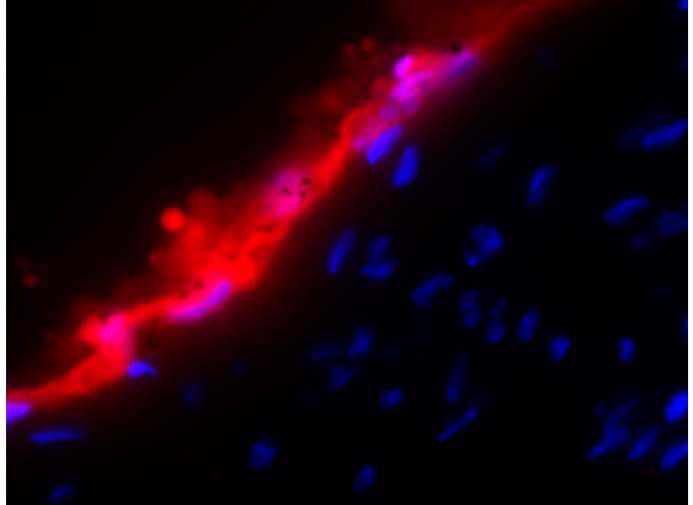
Figure 3. In vivo visualization of RFP expressing Candida . Histology of a GDH2346 ‐ RFP OPC infected IL1r1 − / − mouse showing RFP expression in the fungal biofilm at the dorsal surface of the tongue (5 μ m section stained with DAPI and imaged with a scanning fluorescent microscope (63×)).